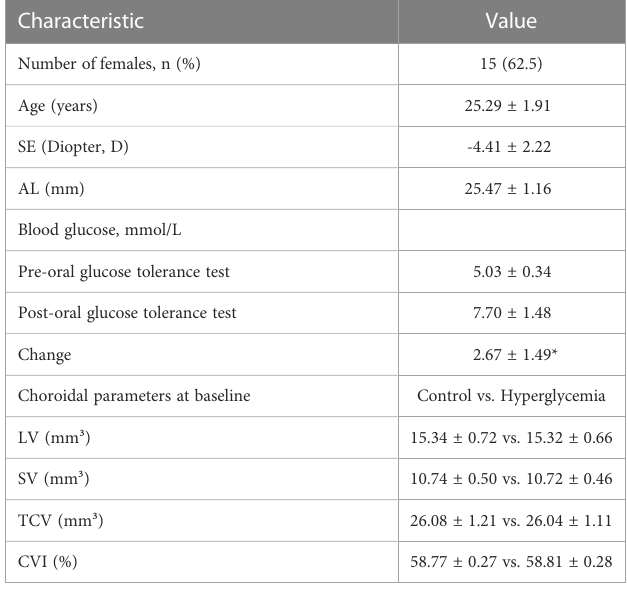
TABLE 1 Participants ’